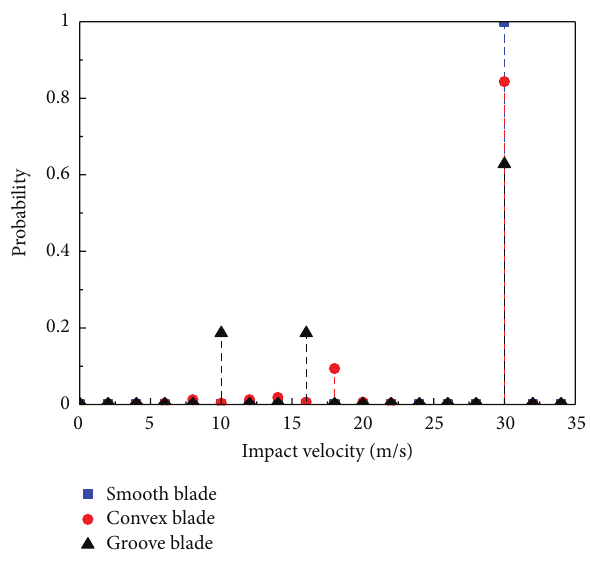
Figure 7: Particle-surface impact velocity distribution.